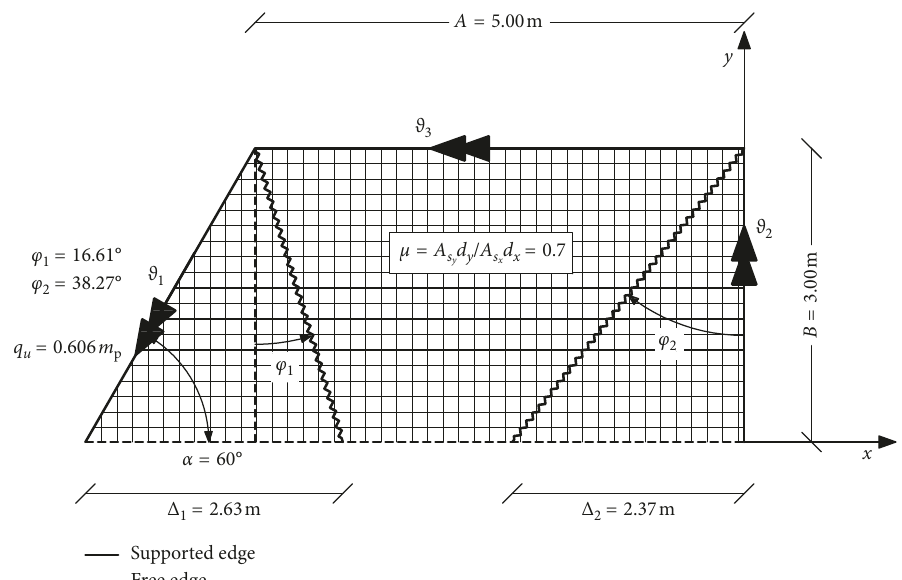
Figure 1: Trapezoidal R/C slab reinforced by a grid of steel bars with stronger reinforcement parallel to the free edge.